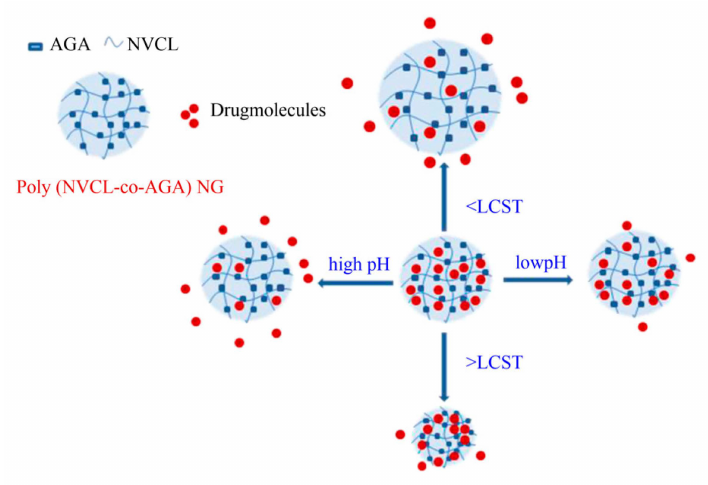
Figure 4. pH and temperature responsive nature of NGs [85]. (Reproduced from Madhusudana Rao et al., Colloids Surf. B 2013 , 102 , 891–897 (Ref. 87) copyright 2013 with permission from